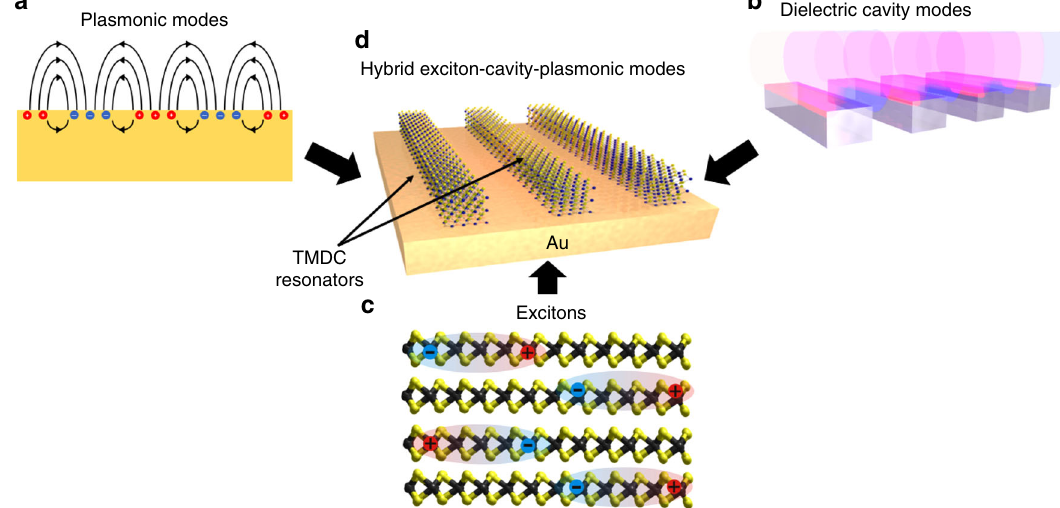
Fig. 1 Conceptual illustration of multipartite light – materials interaction within nanoscale materials and patterned structures. Light interaction with nanostructured metals ( a ) and dielectrics ( b ) gives rise to the excitation of plasmonic and dielectric-cavity resonances, respectively. Dispersion of these resonances is determined mainly by the geometry of the system. c Reduced dimensional materials provide a different approach to strong light – materials interaction. Here, sharp optical resonances manifest in the excitation of long-lived bound electron-hole pairs, with layered two-dimensional transition metal dichalcogenides (TMDCs) as prominent examples. d By mixing engineered geometric dispersion in metal-dielectric nanostructures with intrinsic excitonic resonances in TMDCs, a multifaceted, strongly-interacting interplay of photonic and electronic states can be